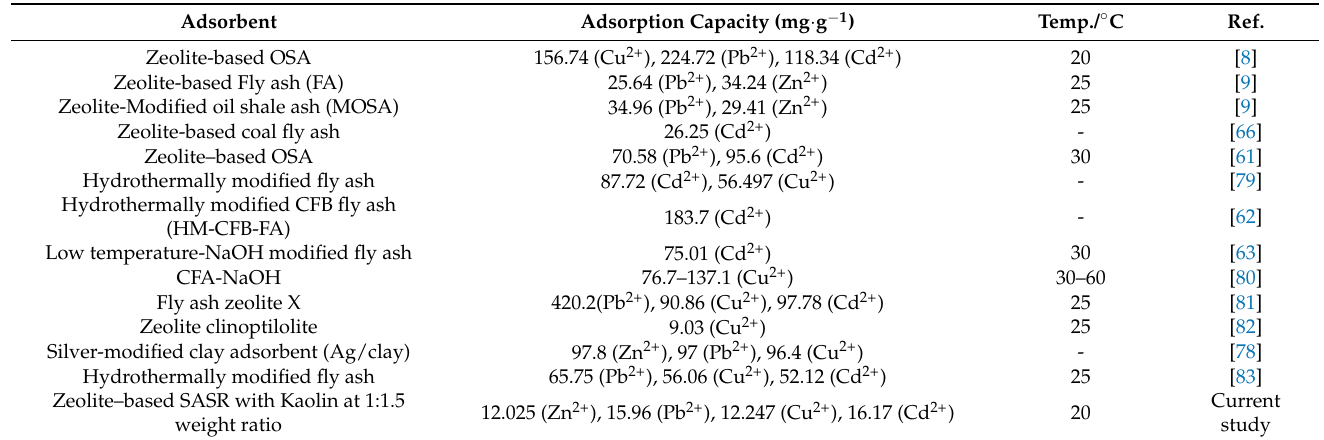
Table 5. A comparison between the different types of cost-effective adsorbents for adsorption of heavy metal